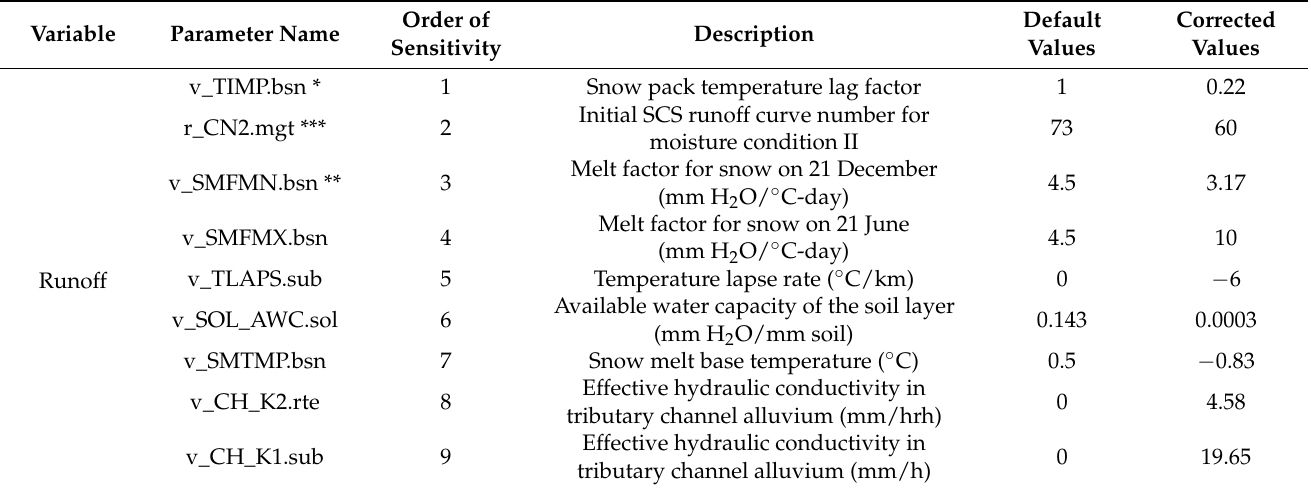
Table 2. SWAT parameters in the Atsuma River